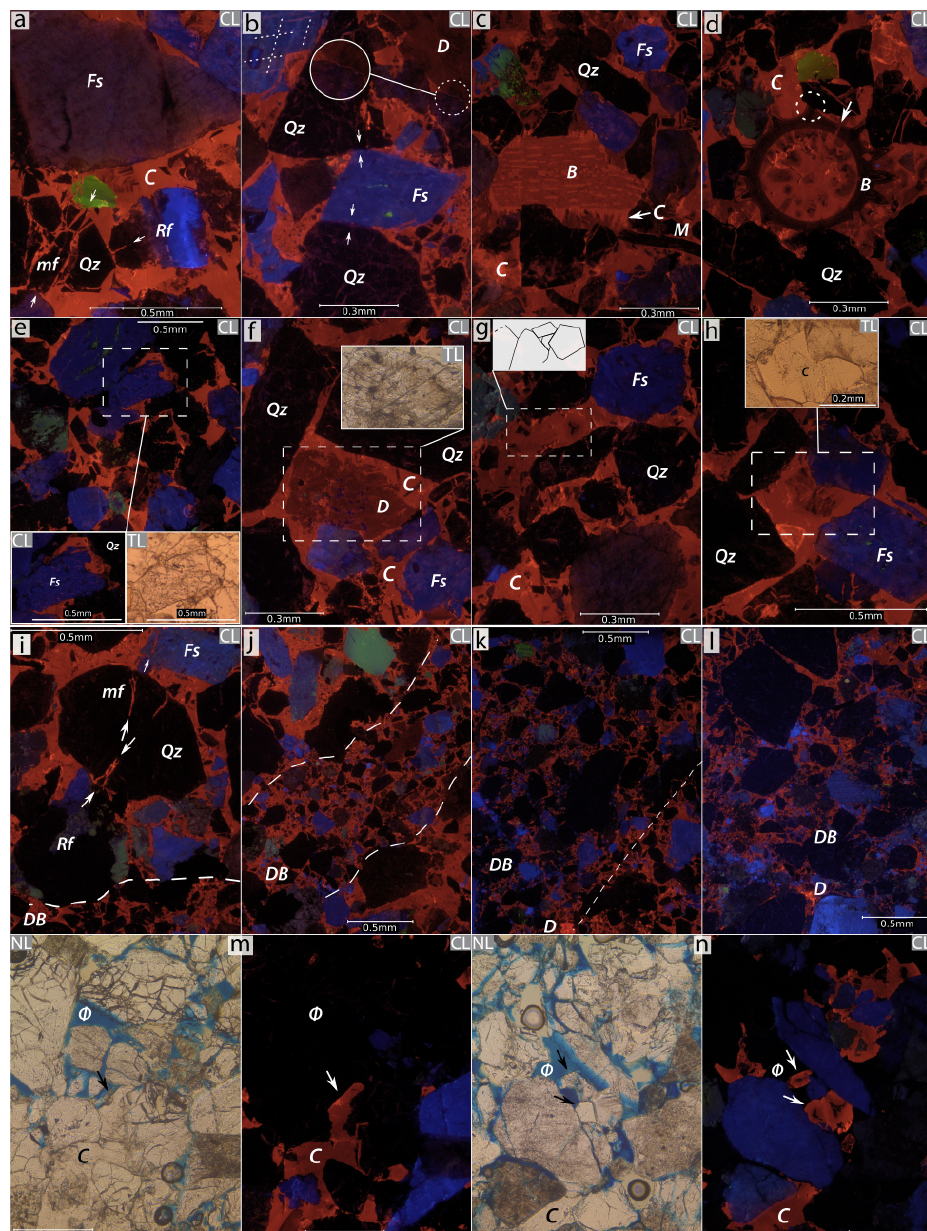
Figure 10. Natural- and CL-light photomicrographs showing the microstructure and cement textures in (a–h) bedding-parallel and (i–n) DB- parallel nodules. (a–b, d) Microfractures form at grain contacts due to stress concentration at contact points, and (i) they are common in the host rock areas close to the DB. (b) Feldspars break mainly by cleavage-controlled intragranular fractures (white dotted line). Some framework grains show planar to slightly undulated framework grain-to-grain contacts. Detrital carbonate clasts and (c–d) bioclasts are partially dissolved at grain contacts. (e) Some detrital grains are corroded and coated or partially replaced by cement. (f) Syntaxial overgrowth cement on a detrital carbonate clast (D). Bright CL (c) circumgranular pore lining (dogtooth texture) and (d) intraskeletal (drusy mosaic) calcite cement were observed only in bedding-parallel nodules. The main cement phase is characterized by bright-orange to orange CL calcite cement that fills intergranular porosity and intragranular fractures both in (a, b, e–h) bedding-parallel nodules and (i–n) DB-parallel ones. (g–h, m–n) Host rock volumes in nodules are characterized by blocky sparite to poikilotopic calcite cement with minor dark CL subzones, whereas (j–l) the cement in DBs is fine-grained sparite. (m–n) At nodule edges, cement crystal rims are regular and sharp, suggesting absent or negligible dissolution. Bright grains in (k, l) are detrital calcite (D). Qz – quartz; Fs – feldspar; M – mica; Rf – rock fragment; B – bioclast; φ – pore space; C – calcite cement; TL – transmitted light. See text and Supplement S1 for further